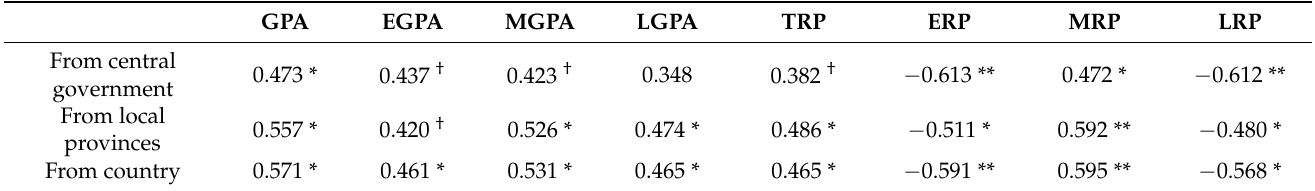
Table 3. Pearson correlation coefficients (R) between rice yield and the annual released number of new rice cultivars (ARC).